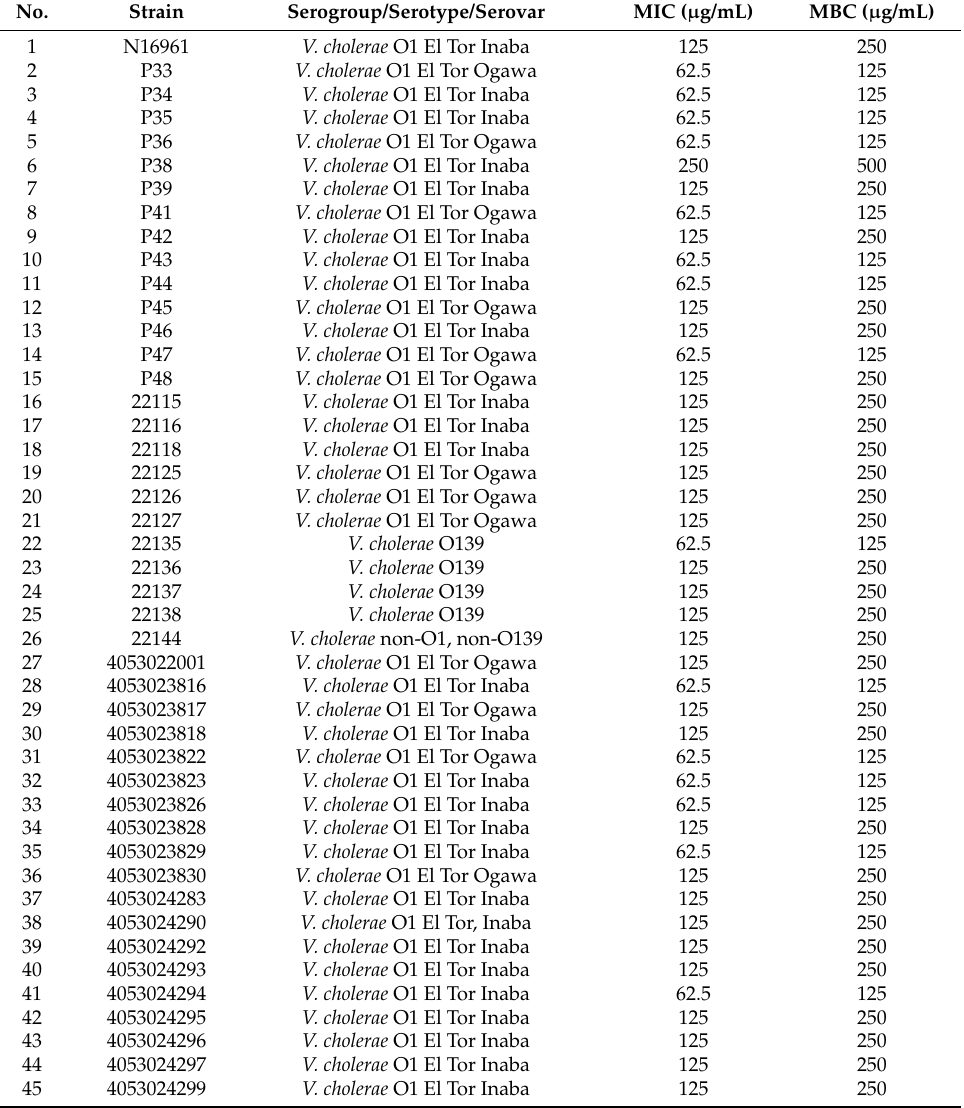
(1/45), which corresponds to 64.44%, 33.33%, and 2.22%, respectively. Meanwhile, the bactericidal activity of EGCG showed MBC values of 250 µ g/mL (29/45), followed by 125 µ g/mL (15/45) and 500 µ g/mL (1/45), as shown in Table S1. On the other hand, the MIC and MBC values of tetracycline–a positive control antibiotic–for drug-resistant V. cholerae strains were shown to range from 0.48 to 62.5 µ g/mL and 0.97 to 125 µ g/mL, respectively (Table S2). This suggests that the effects of EGCG on antimicrobial activities vary depending on the V. cholerae clinical strains. Table 1. MIC and MBC of EGCG for a total of 45 drug resistant V. cholerae strains.